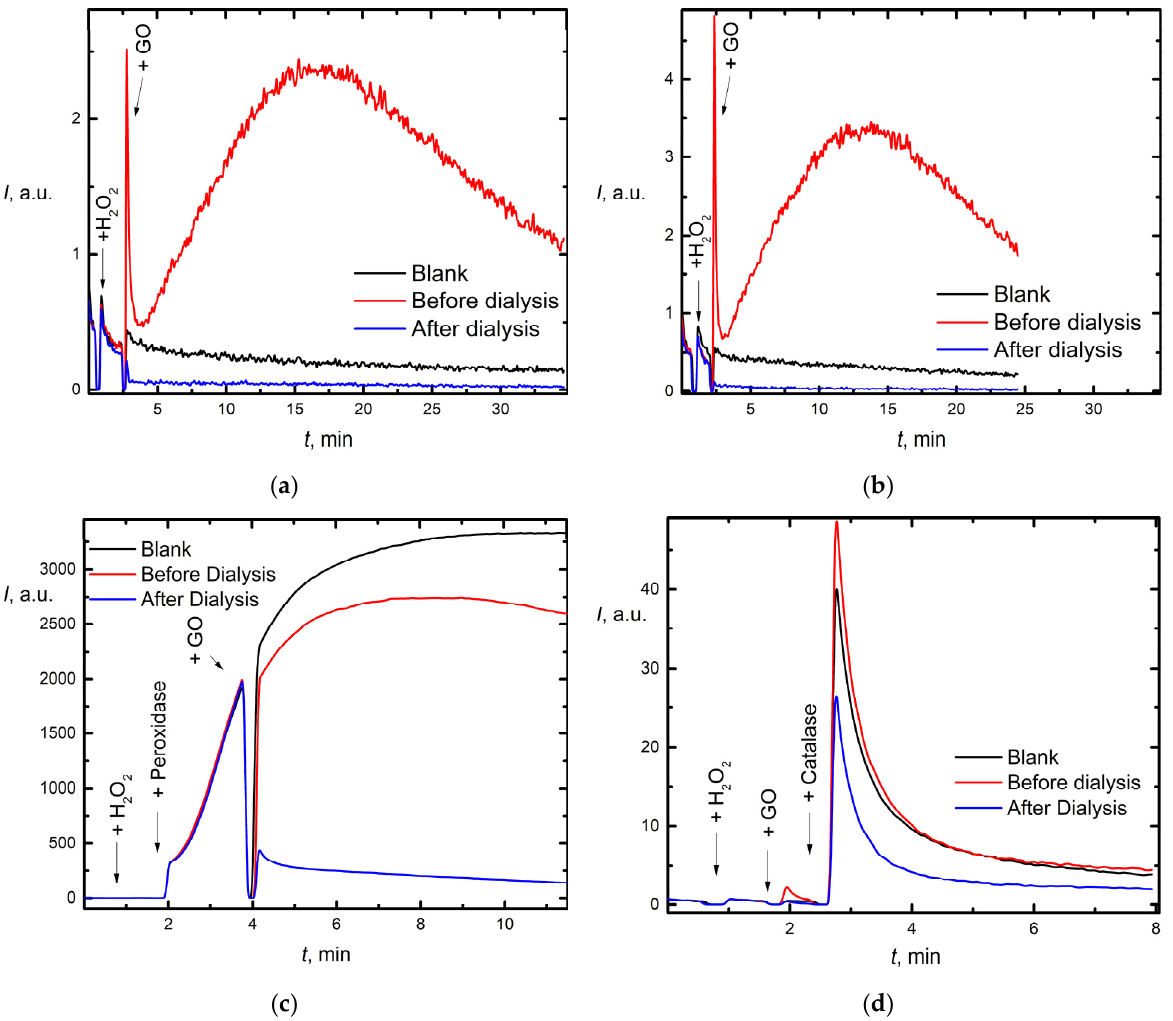
Figure 7. Peroxidase and catalase activities of GO by chemiluminescence with L-012 (40 µL, 1 mM) and H 2 O 2 (10 µL, 0.1 mM) in PBS pH 7.4. Chemiluminescence kinetics of the model system in presence of ( a ) 1 mg/L aqGO, ( b ) 2.5 mg/L aqGO; ( c ) Peroxidase (20 µL, 0.2 µM) and 1 mg/L aqGO, ( d ) Catalase (10 µL, 7 µM) and 1 mg/L aqGO. The total volume, 1.00 mL; temperature, 37 °C.